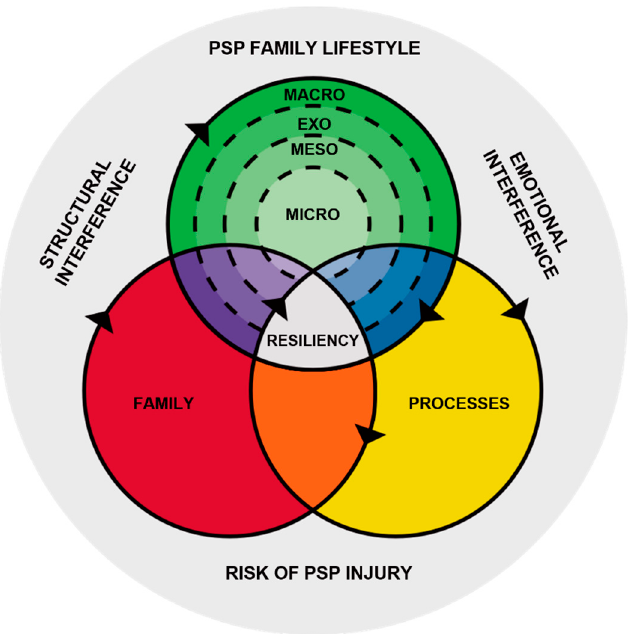
Figure 2. Synthesis of Public Safety Employee Family Resiliency Factors. Adapted from: Synthesis of Military Family Resilience Factors [16].